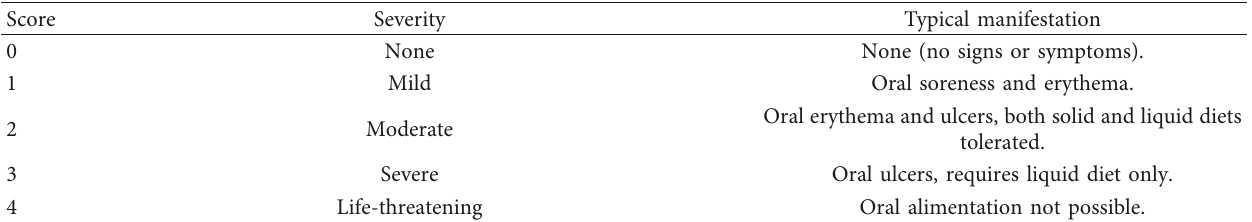
Table 2: Classification of oral mucositis (adapted from WHO